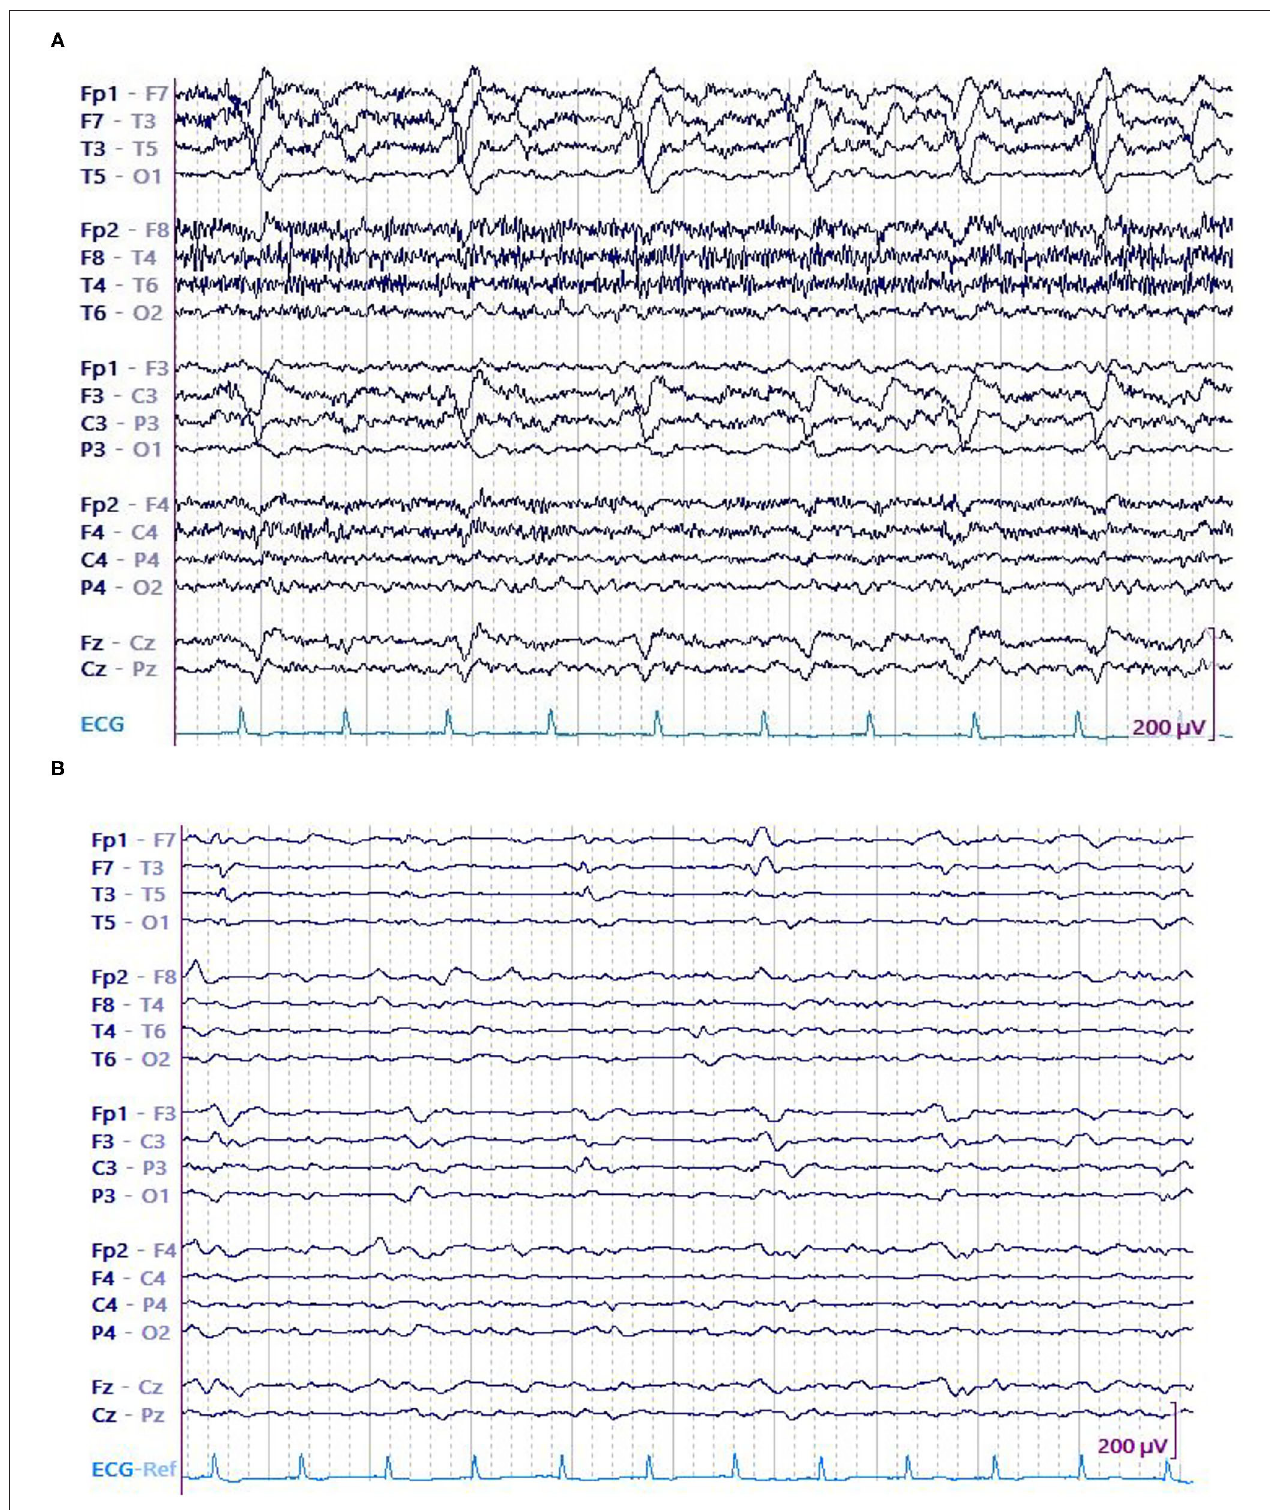
FIGURE 4 | A 75 y/o woman presenting with parieto-temporal mass underwent cEEG. Her EEG showed high amplitude left temporal LPDs occurring at 0.5Hz and brief electrographic seizures over the left temporal region. Patient was started on anti-seizure medications that include levetiracetam and valproate. After 28h, no seizures were detected. Amplitude of the LPDs was decreased. (A) LPDs in epoch with seizure. (B) LPDs in epoch without seizure.